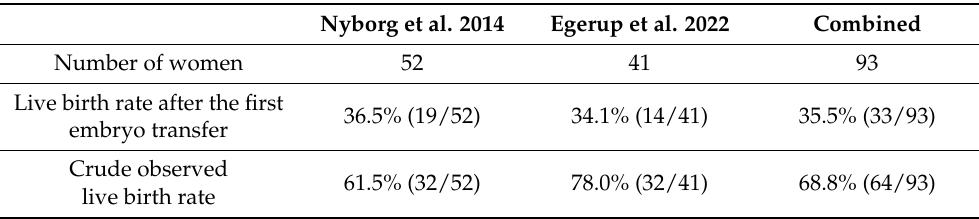
Table 2. Results from the two studies conducted at the clinic regarding immunotherapy (IvIg and PRS) to women with RPL after IVF/ICSI and the combined live birth